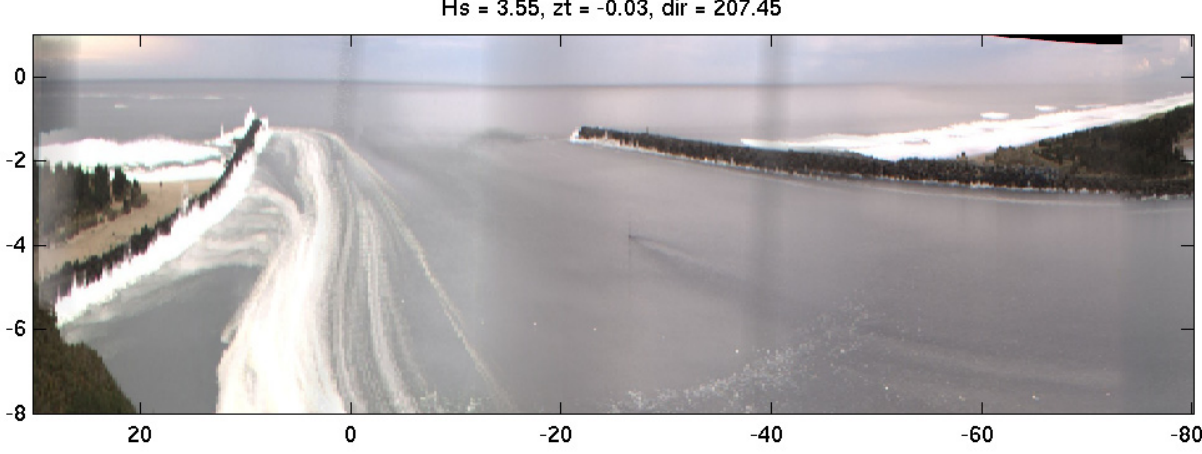
Figure 23. Individual “brightest” pan for 05/18/29, 1730 GMT showing foam being carried landward from the south jetty tip by the flood tide but also a source of foam occurring mid-jetty, near the region of anomalous wave breaking in many pans.